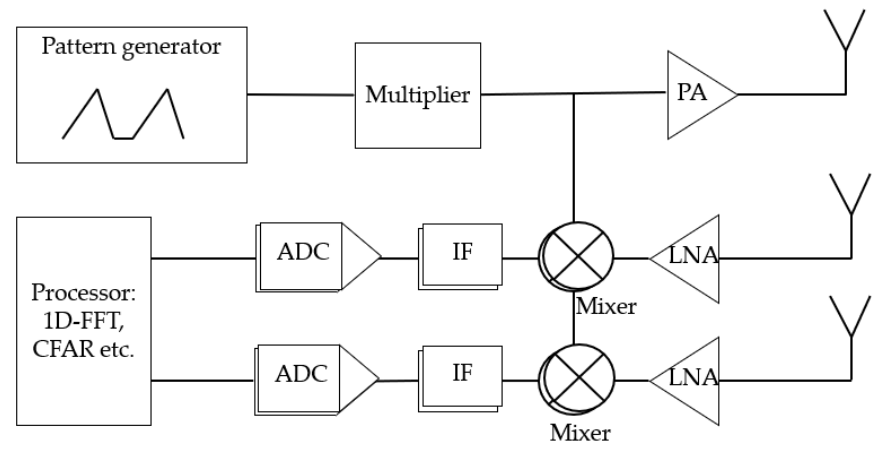
Figure 1. System block diagram of FMCW radar.